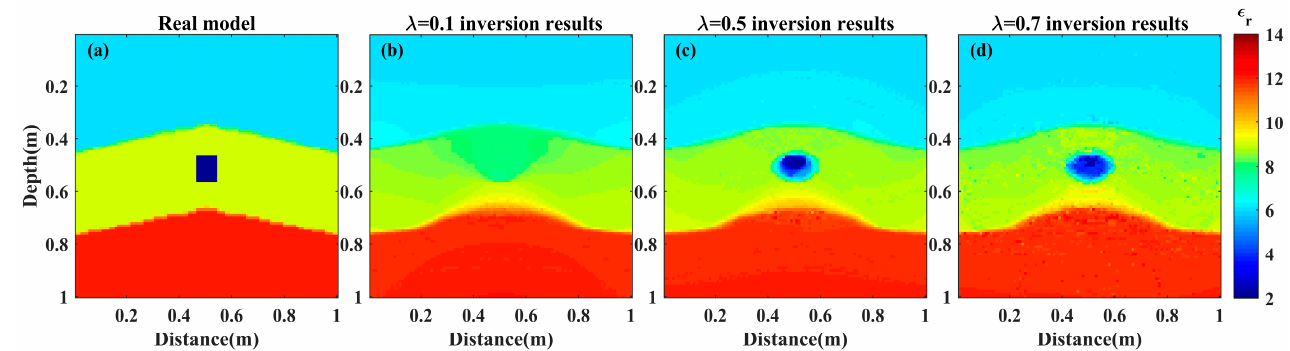
Figure 17. Comparison of inversion results for different regularization factors: ( a ) real model; ( b ) λ = 0.1; ( c ) λ = 0.5; ( d ) λ = 0.7.